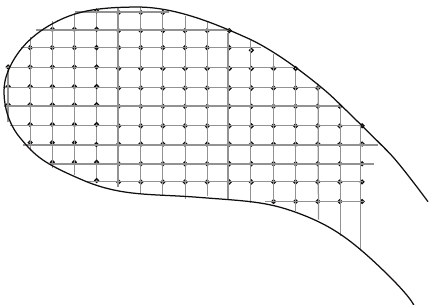
Figure 1: Mesh of particles within the trapping region to obtain average values of the permanence time and the settling velocity.